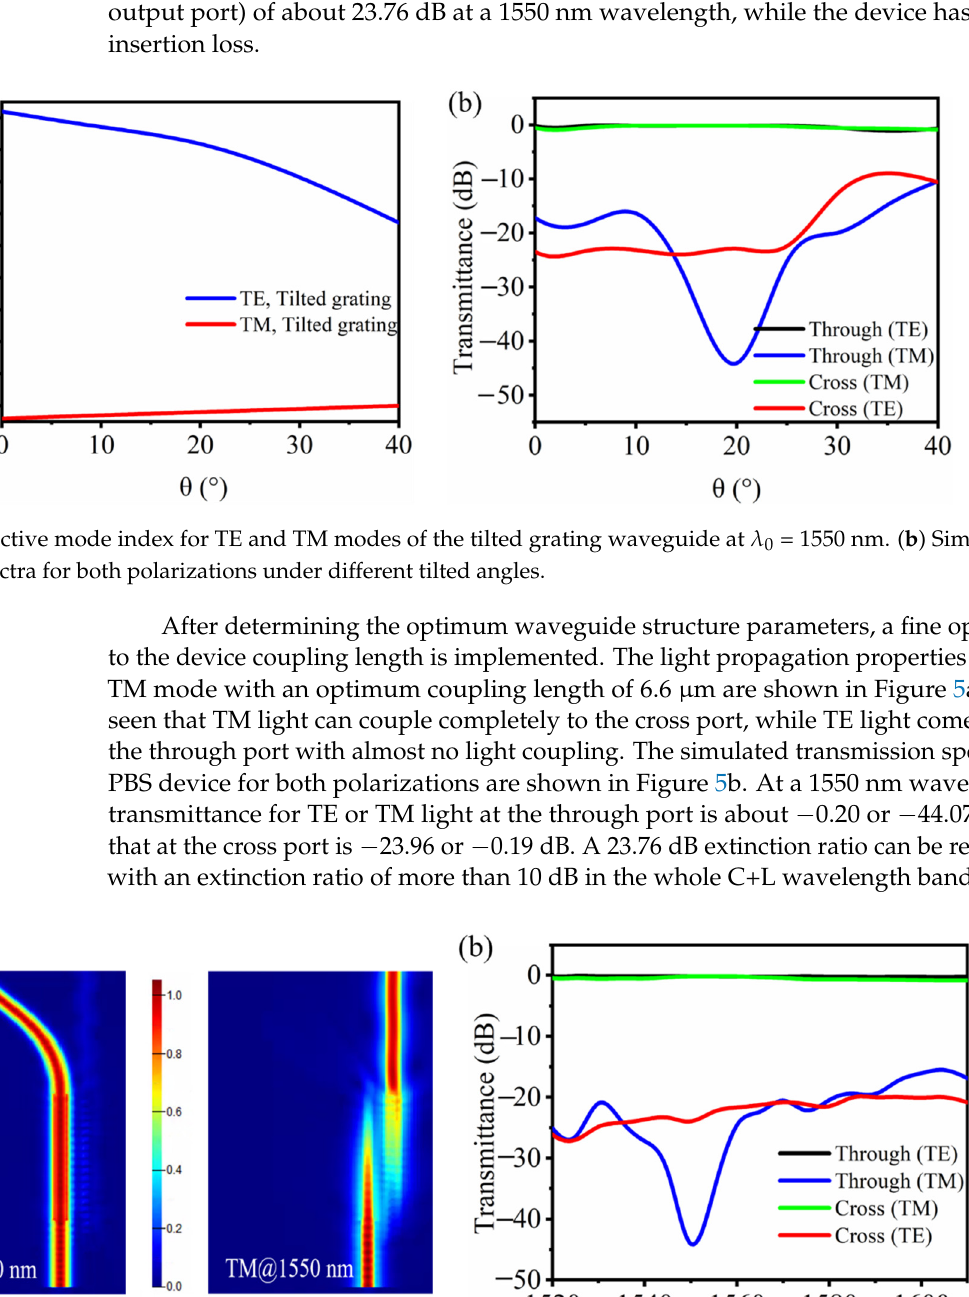
Figure 3. FOM trend for the PSO simulation.